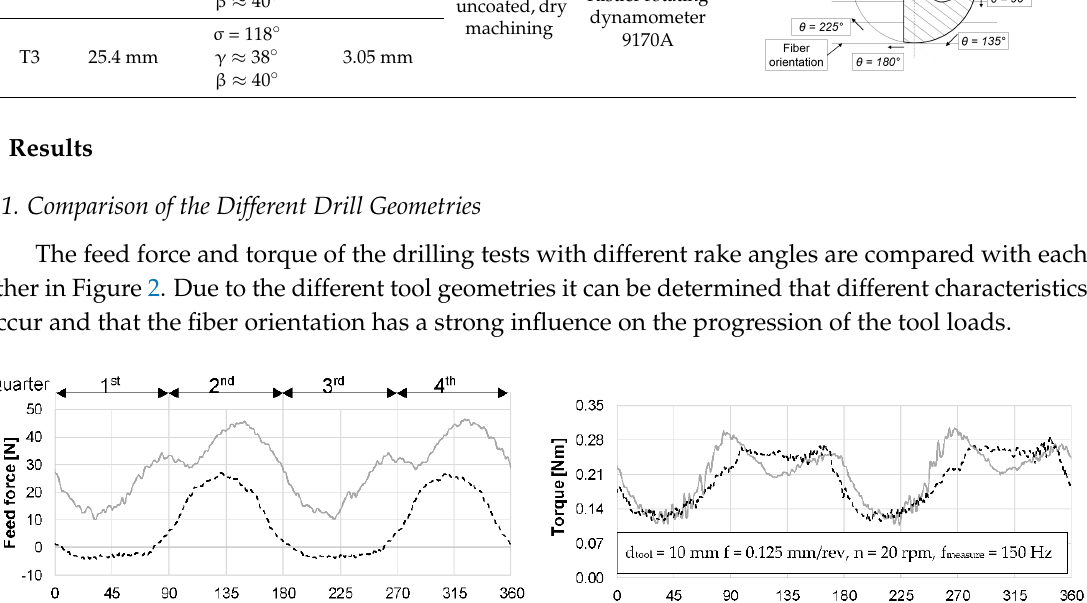
Table 1. Parameters and experimental setup for the test series.